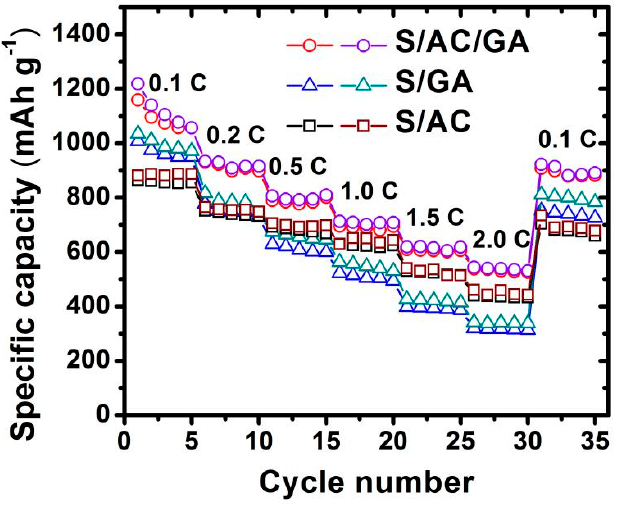
Figure 9. Rate capability of S/AC, S/GA, and S/AC/GA composite electrodes.